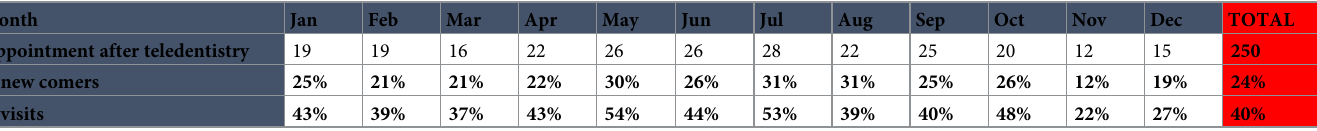
Table 8. Distribution of treatment after teledentistry.